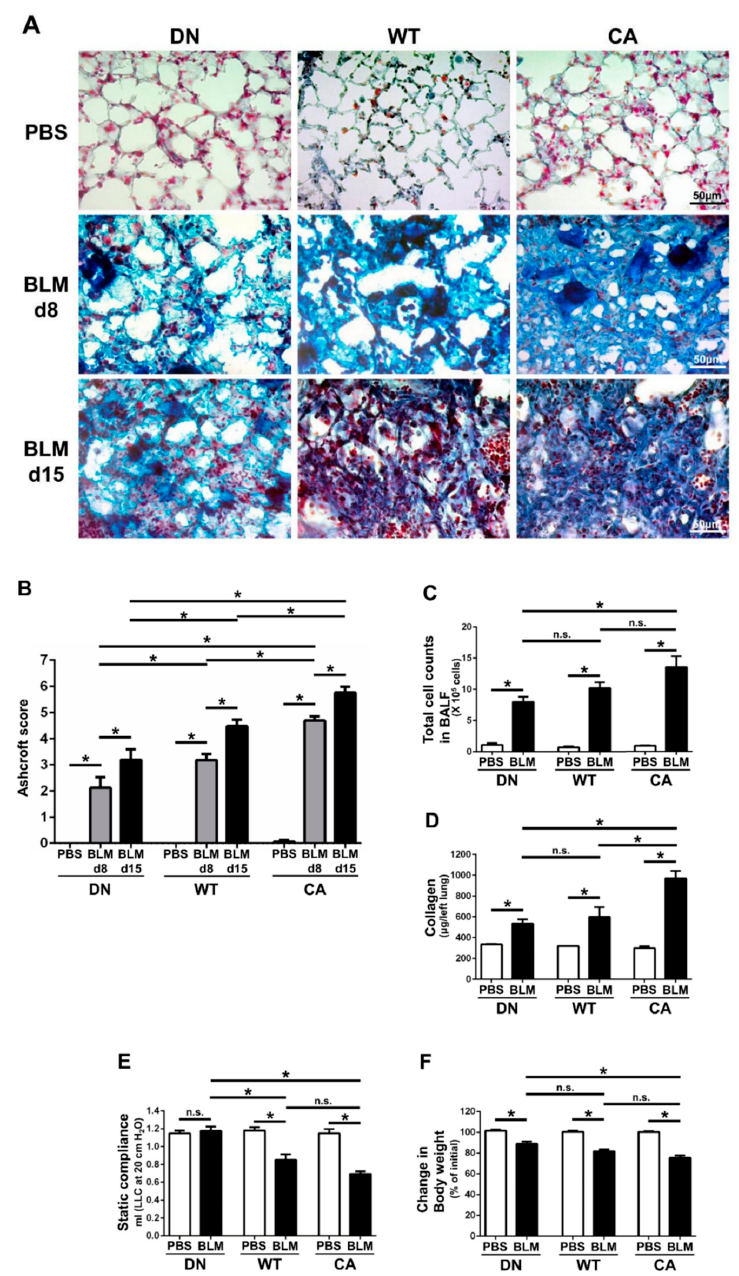
Figure 1. Bleomycin (BLM)-induced pulmonary fibrosis in mice bearing three di ff erent abilities of p38 in the lungs. The three mouse genotype groups; namely, MKK6 constitutive active group (CA), wild type group (WT), and p38 dominant negative group (DN), were intratracheally administrated BLM and phosphate-bu ff ered saline (PBS). ( A ) Representative histopathological images of the lung sections stained by Masson’s trichrome (scale bar = 50 µ m). Lungs were collected at 8 days post-instillation (dpi) of BLM and PBS, and 15 dpi of BLM. ( B ) Quantification of the fibrotic severity using modified Ashcroft scoring was evaluated in six di ff erent lesions at 8 dpi of BLM and PBS, and 15 dpi of BLM (n = 9). ( C ) The numbers of total cells in bronchoalveolar lavage fluid were measured at 8 dpi of BLM and PBS (n = 7). ( D ) The collagen contents of the left lung lobes were measured at 8 dpi of BLM and PBS and normalized to the weight of each left lung (n = 4). ( E ) The static lung compliances were measured at 8 dpi of BLM and PBS (n = 4). ( F ) Proportions of body weight at 8 dpi of BLM and PBS to that before administration (n = 14). All data are represented as means ± standard error of the mean (SEM). * p < 0.05, n.s., no significant di ff erence (measured by one-way an analysis of variance (ANOVA) followed by Tukey’s test or unpaired Student’s t